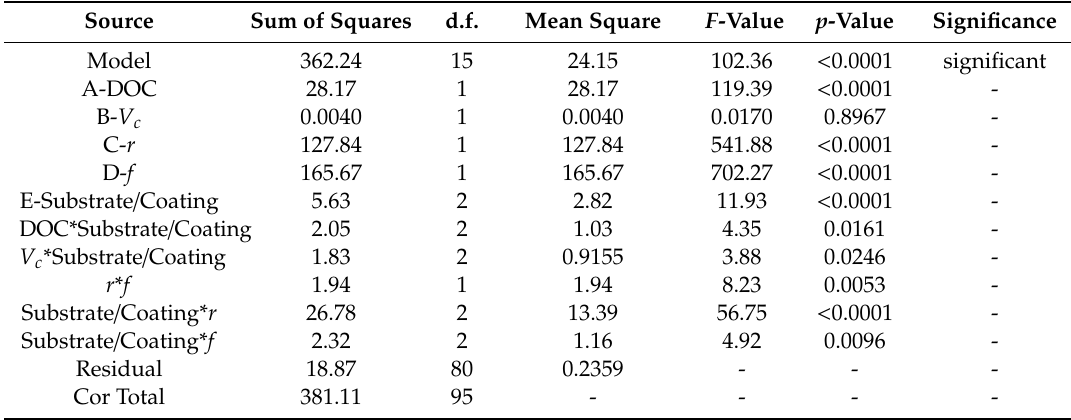
Table 8. ANOVA for reduced 2FI model of the Rz